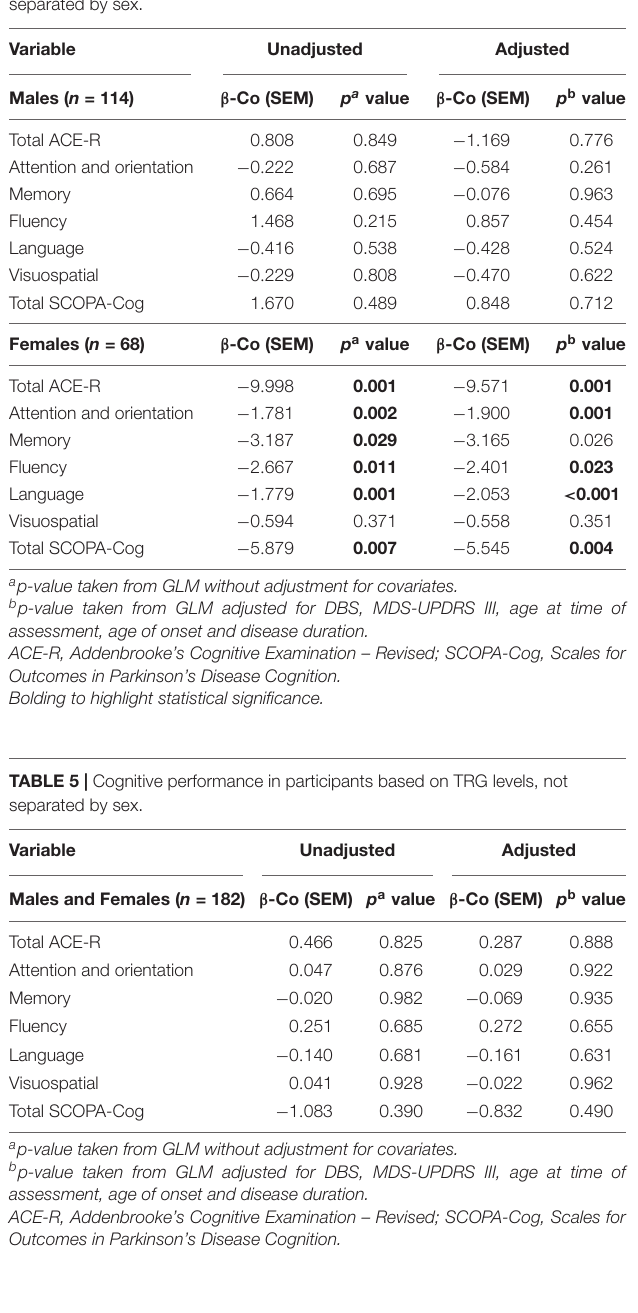
subdomains, attention and orientation, memory, fluency, language and total SCOPA-Cog, but not with visuospatial cognition. In models adjusting for covariates, HDL levels in females were significantly associated with total ACE-R score ( p = 0.001), ACE-R subdomain scores of attention and orientation ( p = 0.001), memory ( p = 0.026), fluency ( p = 0.023) and language ( p < 0.001); and total SCOPA-Cog score ( p = 0.004). However, the visuospatial domain did not exhibit a significant association with HDL levels in females, regardless of covariate adjustment ( p = 0.351, Table 4